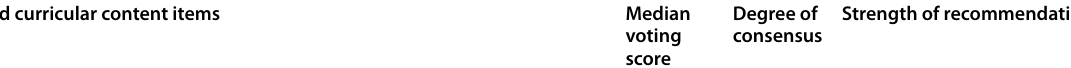
Table 4 List of all curricular content items in Domains 4 with the median appropriateness score for Round 2, the degree of